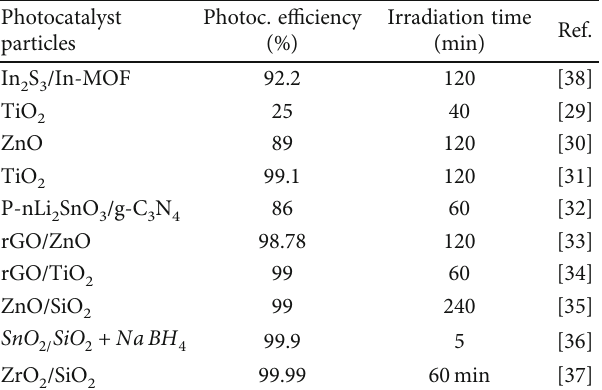
Bandgap energy (ev)